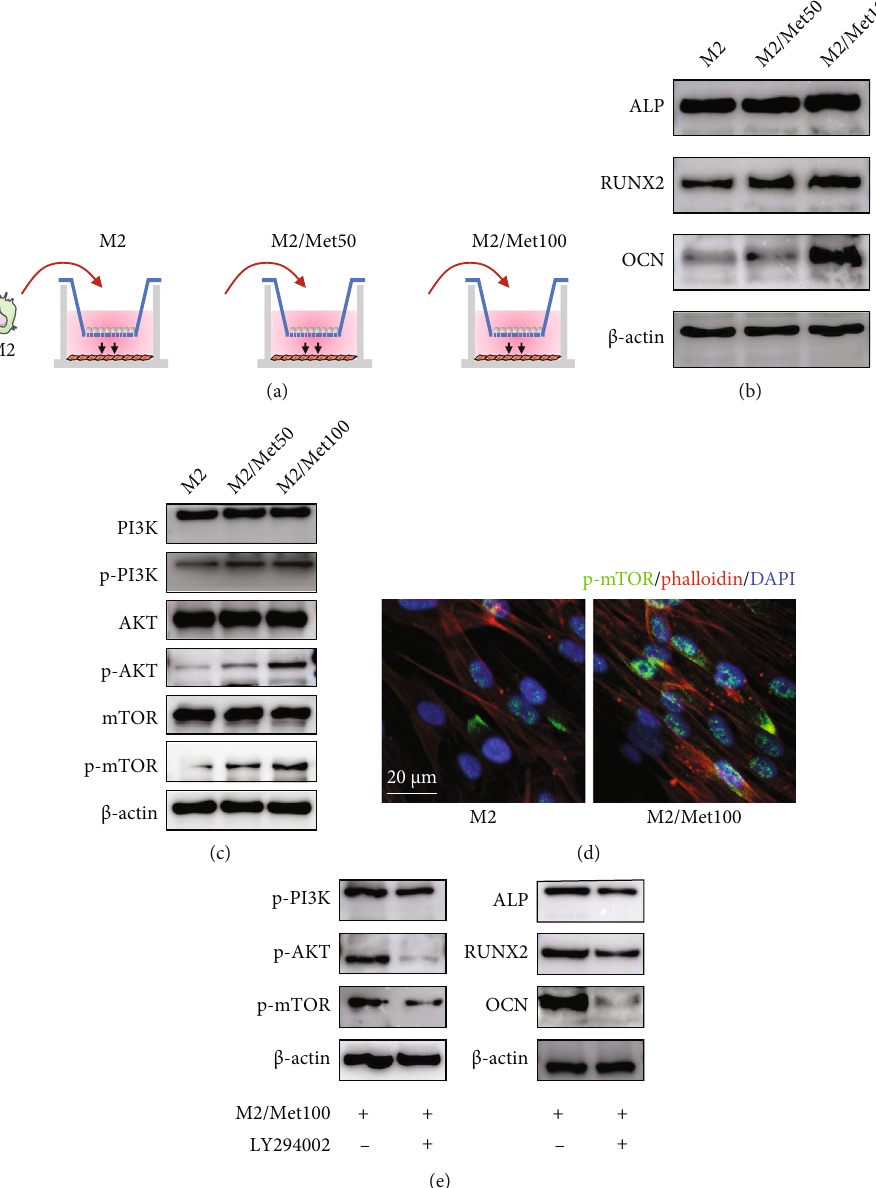
Figure 6: Metformin-pretreated M2 macrophages enhanced osteoblastic di ff erentiation via the PI3K/AKT/mTOR pathway (a) The diagram of metformin (0, 50, and 100 μ M)-treated M2 macrophages cocultured with UC-MSCs. (b) Expression levels of osteogenic-related proteins (ALP, RUNX2, and OCN) after coculture with metformin-treated M2 macrophages for 48 h. (c) Expression levels of PI3K/AKT/mTOR- pathway-related proteins (PI3K, p-PI3K, AKT, p-AKT, mTOR, p-mTOR). (d) Representative immuno fl uorescence staining of p-mTOR in M2-cocultured or M2/Met100-cocultured UC-MSCs. p-mTOR (green), phalloidin (red), and counterstained with DAPI (blue). Scar bar = 20 μ m. (e) Expression levels of p-PI3K, p-AKT, p-mTOR, and ALP, RUNX2, and OCN after treatment with or without LY294002 (50 μ